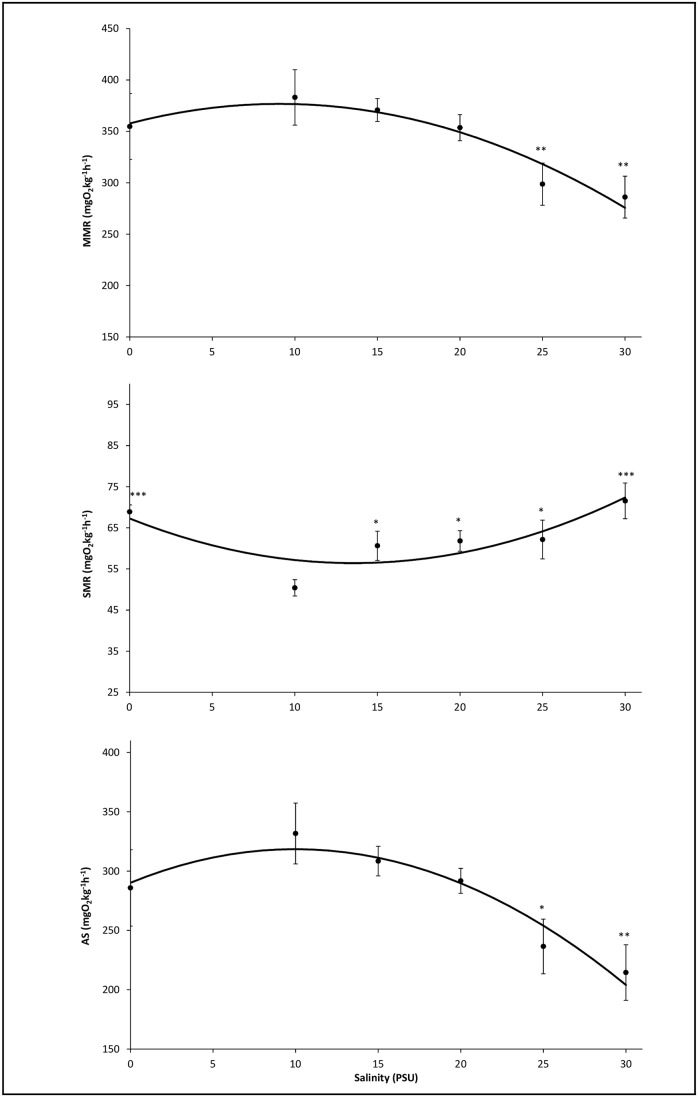
Relationship between ambient salinity and measured averages (circles, mean ± SE) and modelled (lines) round goby maximum metabolic rate (MMR, upper graph), standard metabolic rate (SMR, middle graph), and aerobic scope (AS: MMR minus SMR, lower graph).For all groups n = 8, except for 10 and 15 PSU where n = 7 for MMR and AS. * indicate p<0.05, ** indicate p<0.01 and ***indicate p<0.001.